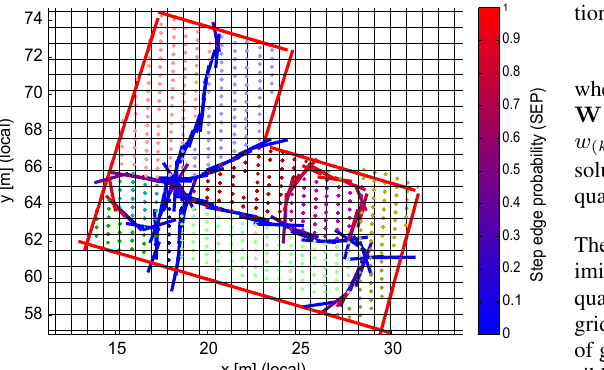
(a) Local boundary lines plotted over the segmented LiDAR points. Each color represents one segment. The lines’ colors indicate diffferent step edge proba- bilities, ranging from zero (blue) to one (red).